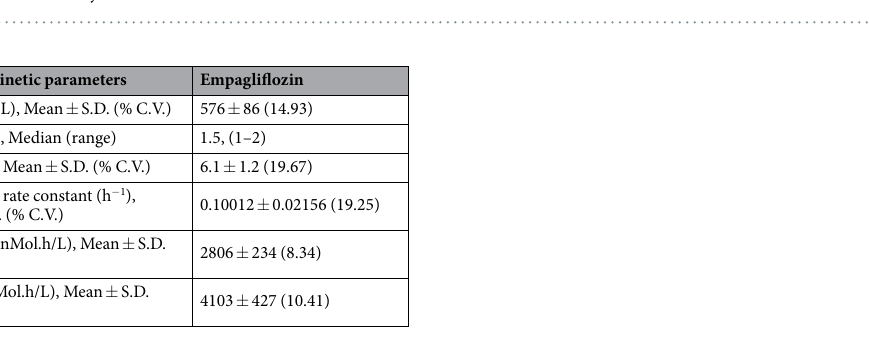
Figure 6. The mean plasma concentration-time curves of empagliflozin after oral administration of one JARDIANCE tablet nominally containing 25 mg of empagliflozin. Each symbol with a bar represents the mean ± S.D. of 6